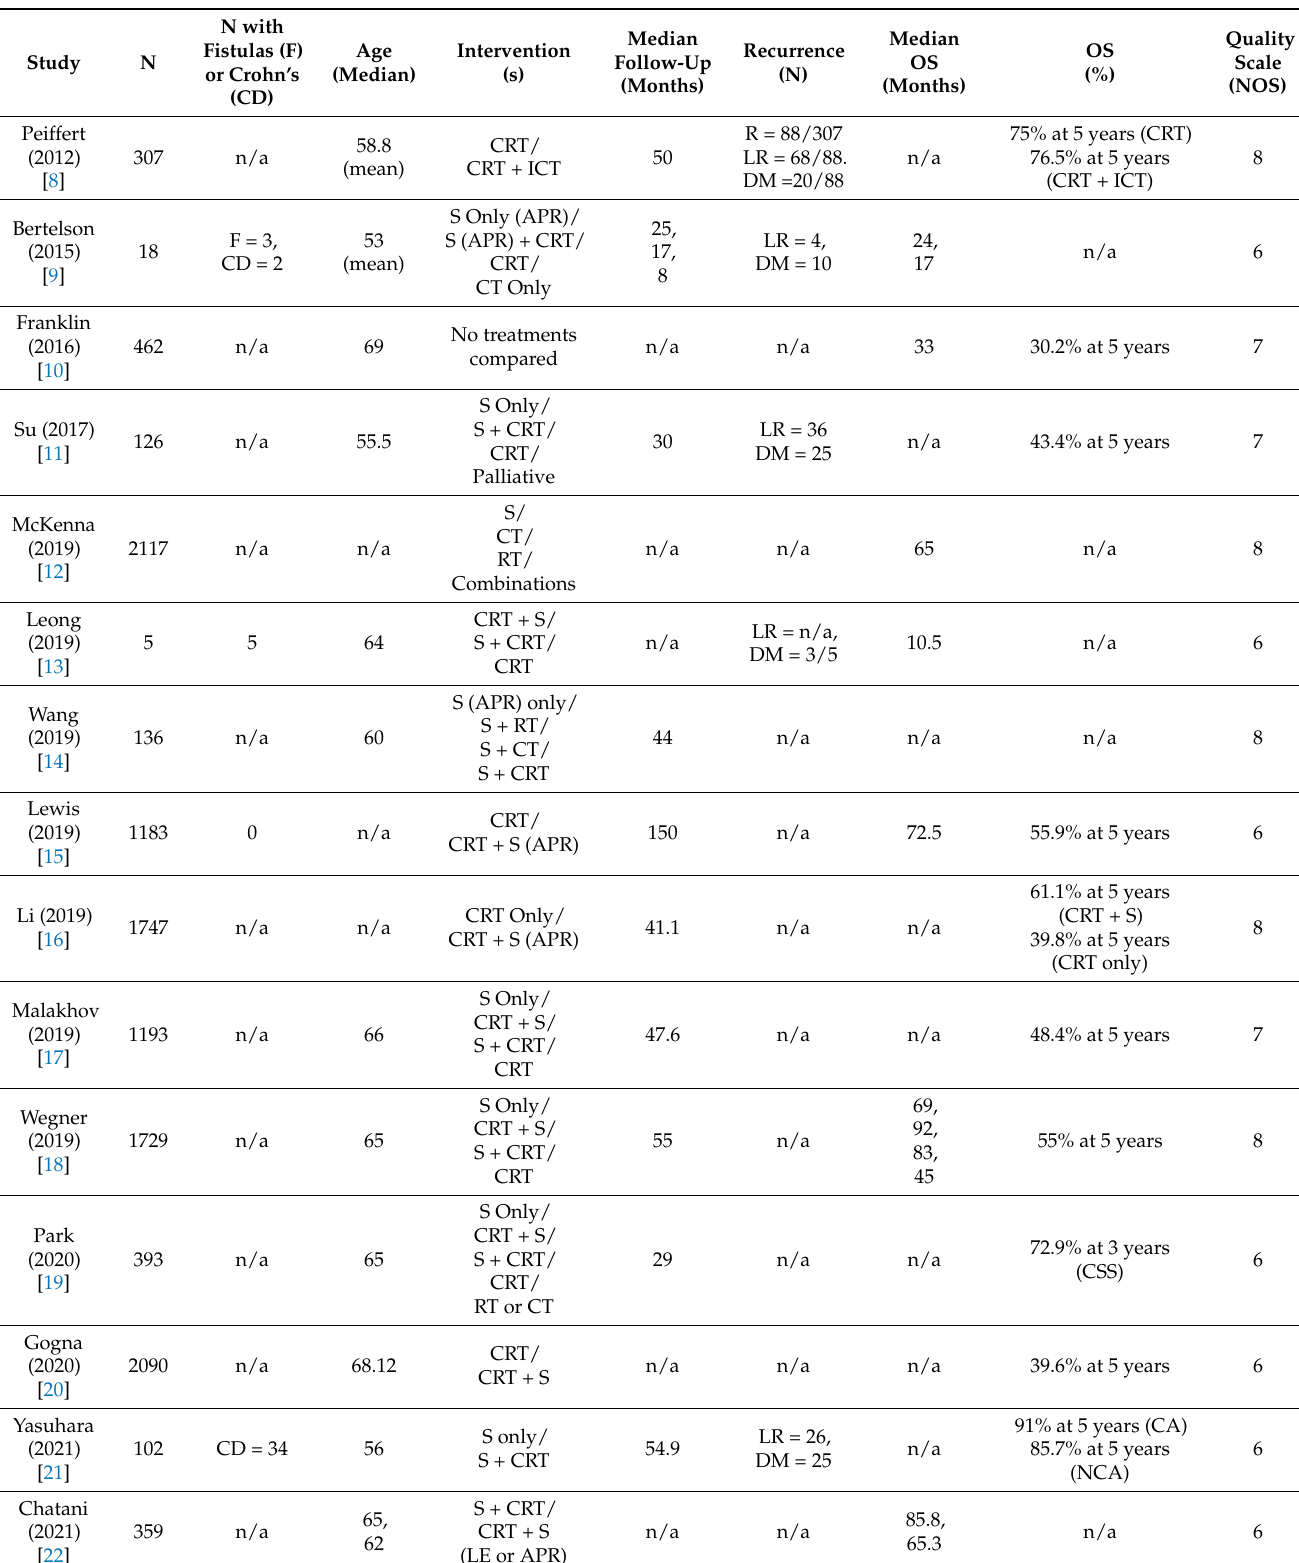
Table 2. Important extracted data of included studies, including OS and recurrence (secondary outcome